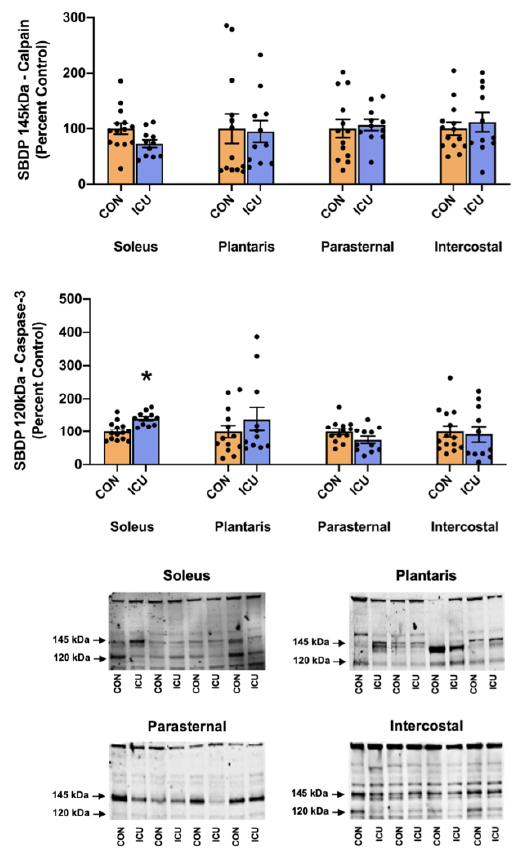
Figure 4. Calpain and Caspase ‐ 3 activity. 145 kDa spectrin breakdown product (SBDP) (calpain ‐ specific cleavage) and 120 kDa SBDP (caspase ‐ 3 ‐ specific cleavage) in the soleus, plantaris, parasternal, and intercostal muscles of control, non ‐ anesthetized, non ‐ ventilated rats (CON), and rats that underwent 12 h of controlled mechanical ventilation (ICU). Representative Western blots are shown below the graph. Data are presented as mean ± SEM. * significantly different vs. CON ( p < 0.05).